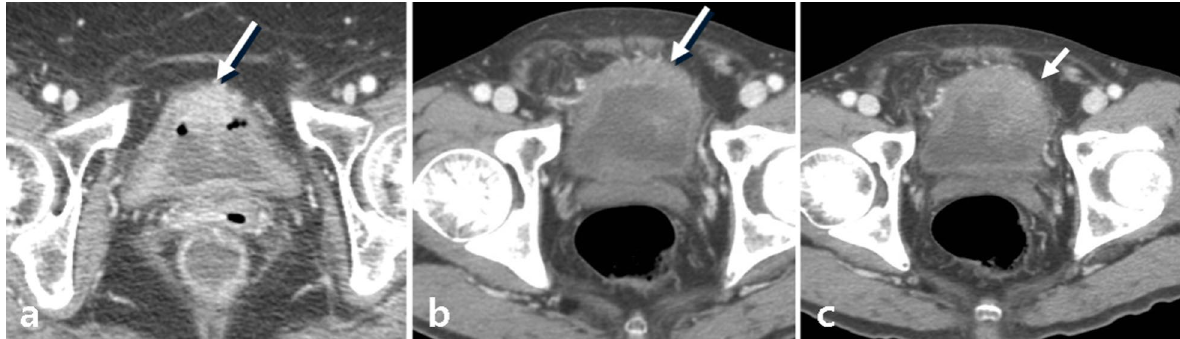
Fig. 4 Two cases of bladder cancer. a Axial urothelial phase CT image of a 67‑year‑old female patient with bladder squamous cell carcinoma shows an enhancing sessile or nodular mass (arrow) in the anterior wall of the bladder. b , c Axial contrast‑enhanced CT images of a 68‑year‑old male patient with bladder adenocarcinoma show diffuse bladder wall thickening (arrow) along the anterior wall of the bladder and a large irregular enhancing intramural mass within the bladder. There is irregular soft tissue stranding (small arrow) from tumor invasion into the perivesical